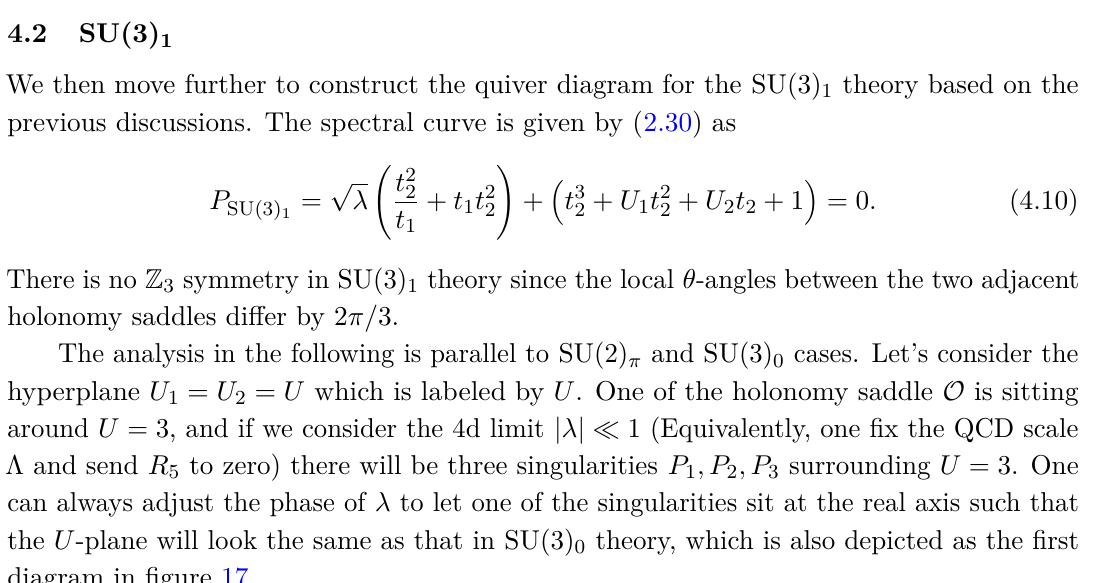
Figure 17 . The U -plane for SU(3) 1 theory and the path connecting the two observers O and O 0 probing the two holonomy